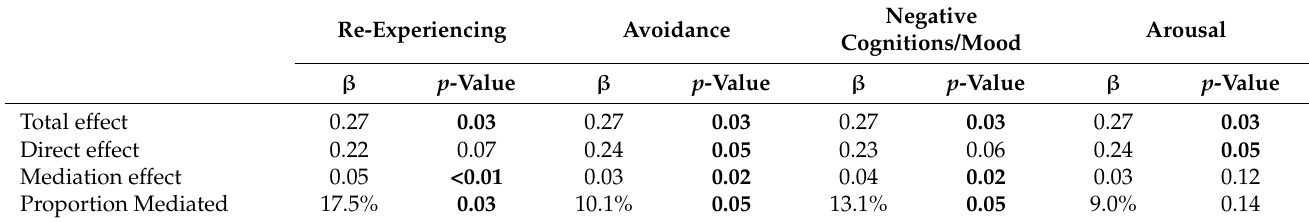
Table 4. Mediation effect of each PTSD symptom cluster (sub-PCL score) in the association of WDCTE and CRP level (log(CRP)), adjusted for demographic characteristics and lower respiratory